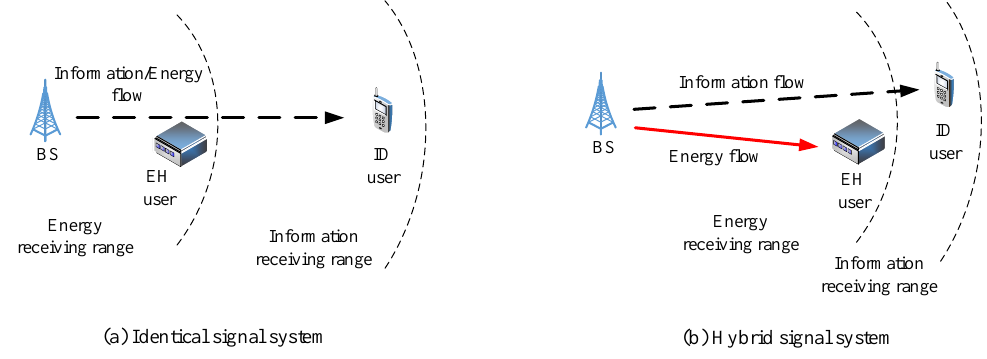
Figure 2. Illustration of SWIPT systems with identical and hybrid signaling